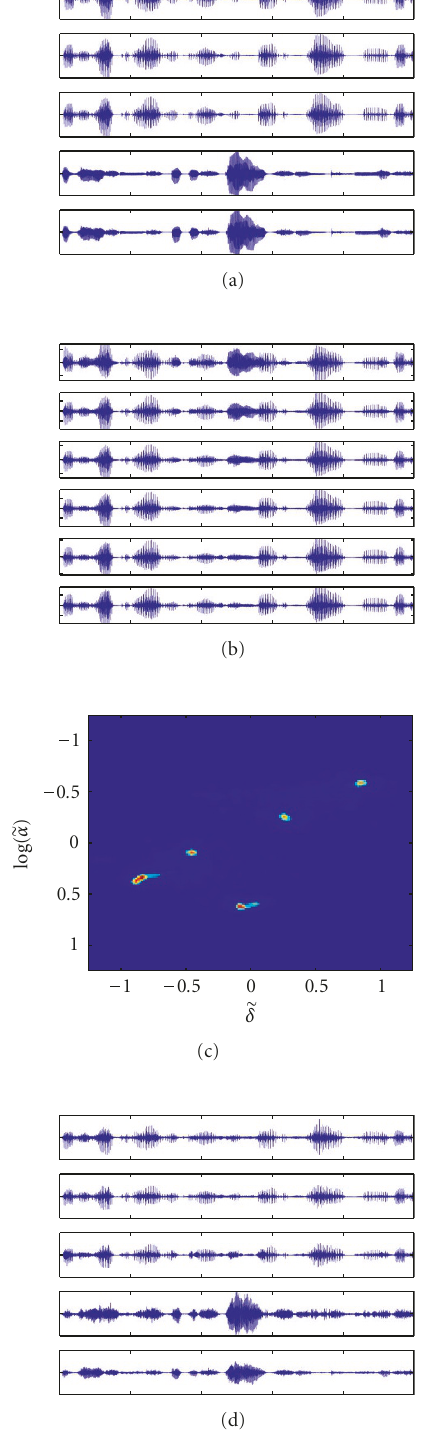
Figure 8: Underdetermined blind source separation in a simple echoic environment via echoic DESPRIT: (a) 2 speech sources trav- elling upon 3 and 2 paths, respectively, (b) 6 echoic mixtures of the 2 signals, (c) the two-dimensional power weighted histogram shows 5 peaks from which (d) 5 demixtures are recovered, 3 of which cor- respond to the first source and 2 of which correspond to the second source.